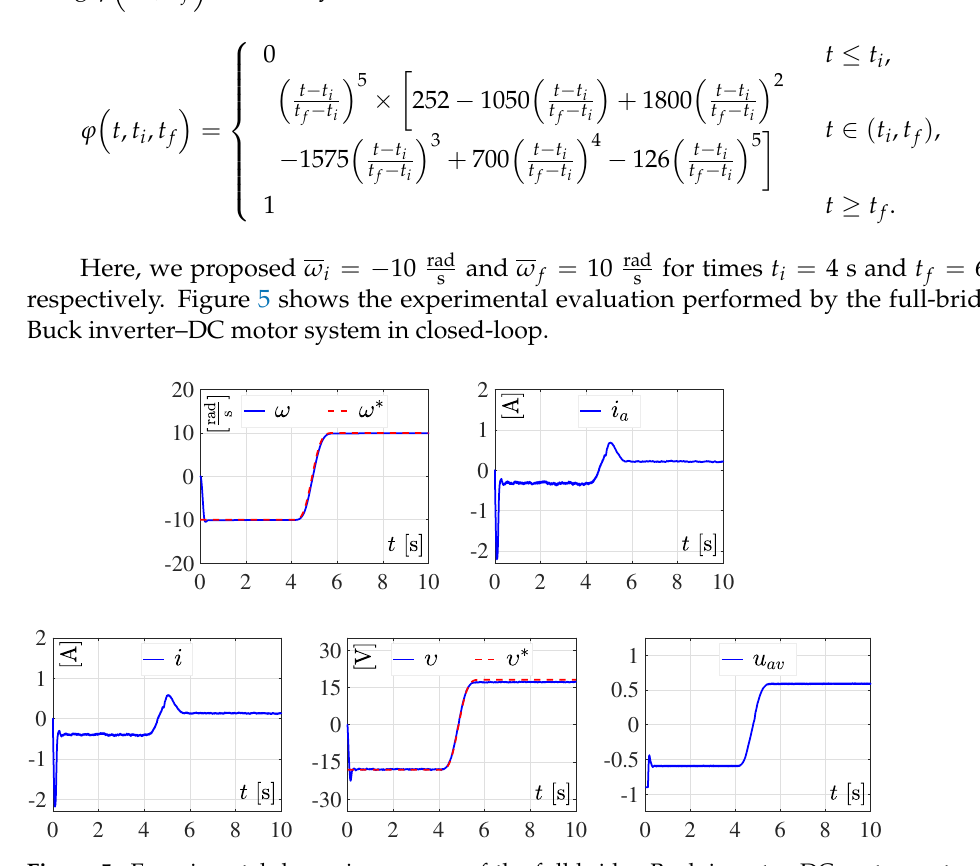
Figure 5. Experimental dynamic response of the full-bridge Buck inverter–DC motor system in closed-loop for the first desired trajectory ω ∗ (22).